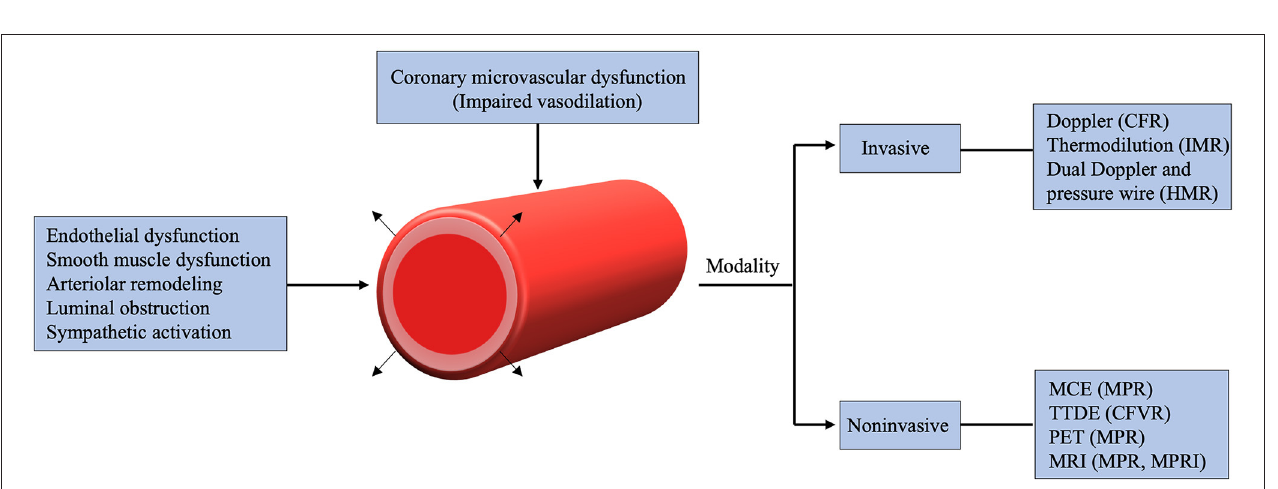
FIGURE 2 | Mechanisms and various imaging modalities of coronary microvascular dysfunction. CFR, coronary flow reserve; CFVR, coronary flow velocity reserve; HMR, hyperemic microvascular resistance; IMR, index of microcirculatory resistance; MCE, myocardial contrast echocardiography; MPR, myocardial perfusion